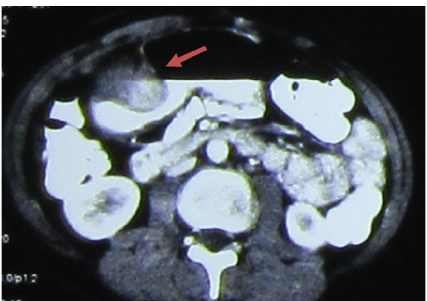
Figure 1: Abdominopelvic CT scan with IV and oral contrast. A 5cm × 6cm soft, hypodense mass along the anterior wall of the gastric antrum with subsequent pyloric stenosis and luminal ob- struction with gastric dilatation in the body and fundus (the red arrow indicates the mass).